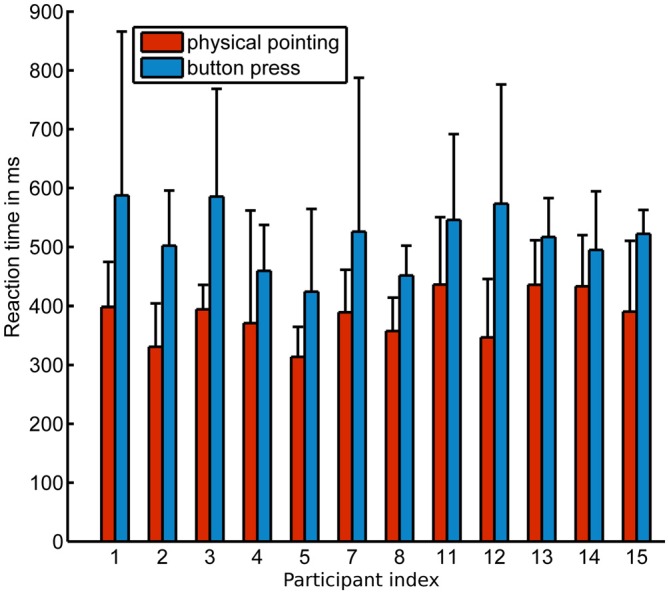
Mean onset response times (threshold criterion 5% of subsequent max. velocity) for all participants in the physical pointing and button press condition.
x-axis displays the participant index, y-axis the response time in ms. Error bars show standard deviation.